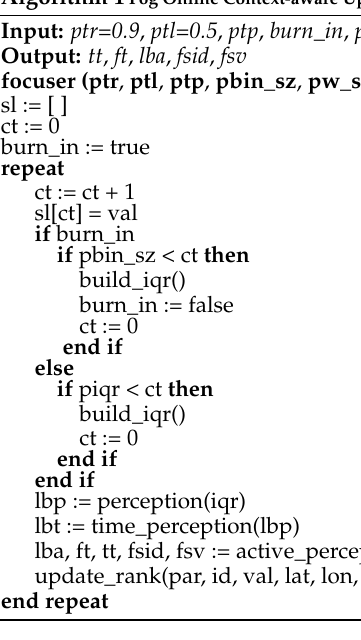
Table 3. List of abbreviations used in Algorithm